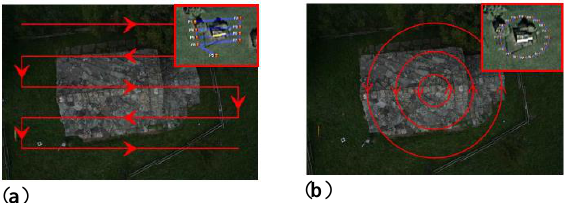
Figure 5: Flight Path Shapes ( a ) Linear Pattern ( b ) Circular